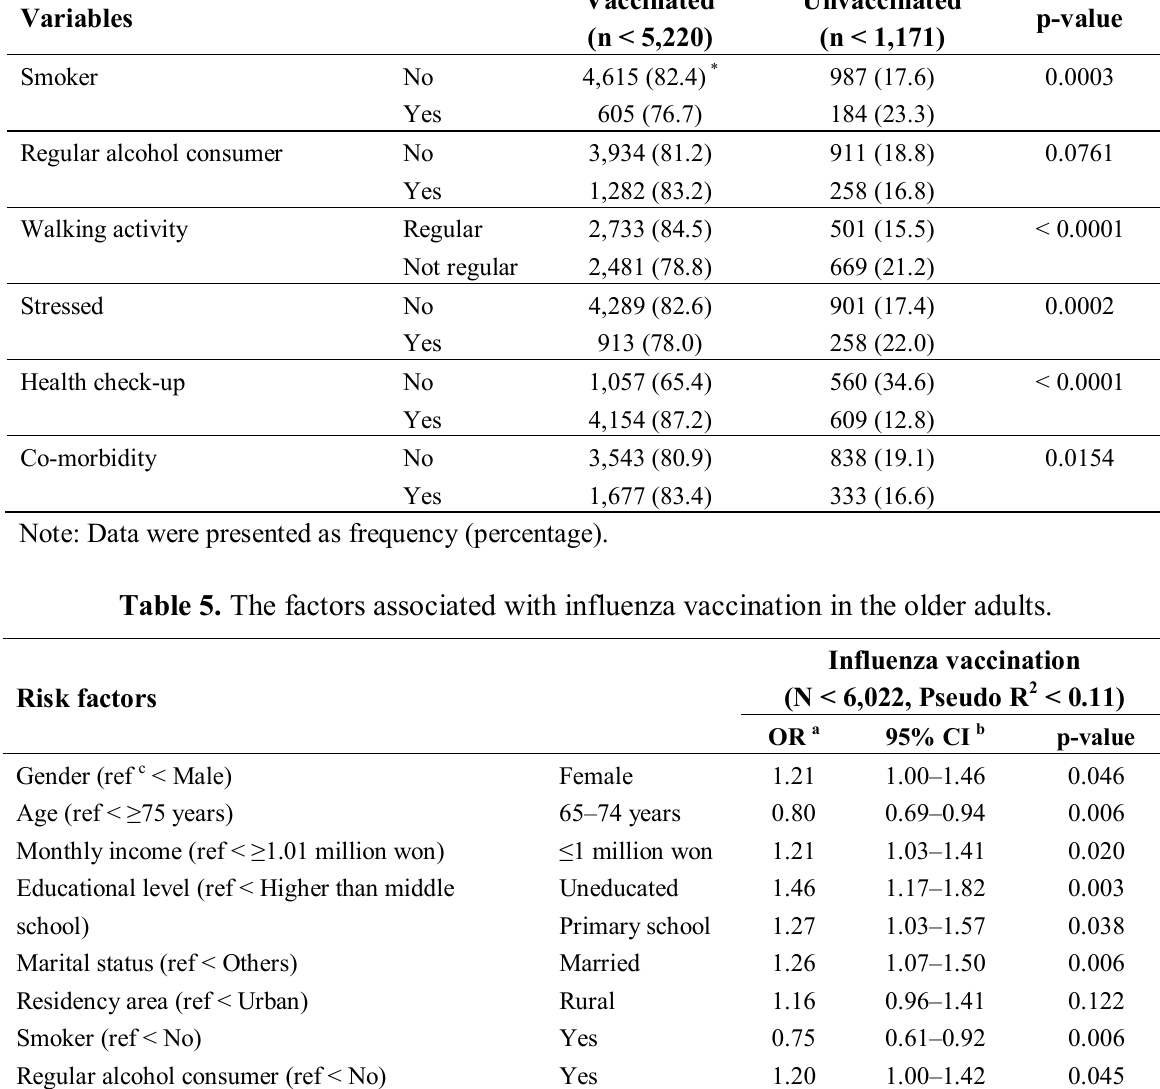
Table 4. Influenza vaccination rates according to lifestyles and health-related factors. Variables